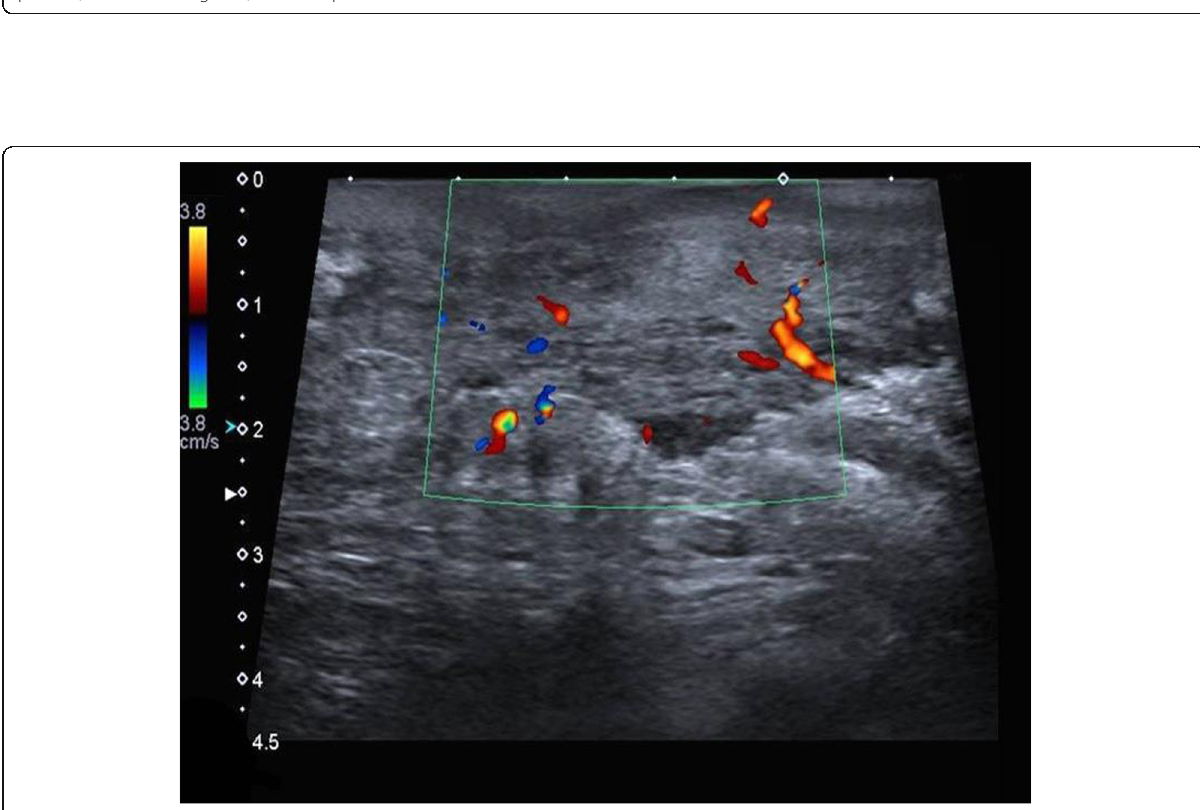
Fig. 3 B-mode ultrasound showed an ill-defined area of parenchymal distortion with marked internal vascularity, no definite masses, assessed as BIRADS 4C. Pathology: DCIS (grade II). Biological markers: ER positive, PR negative, HER/neu-2 positive, and Ki67